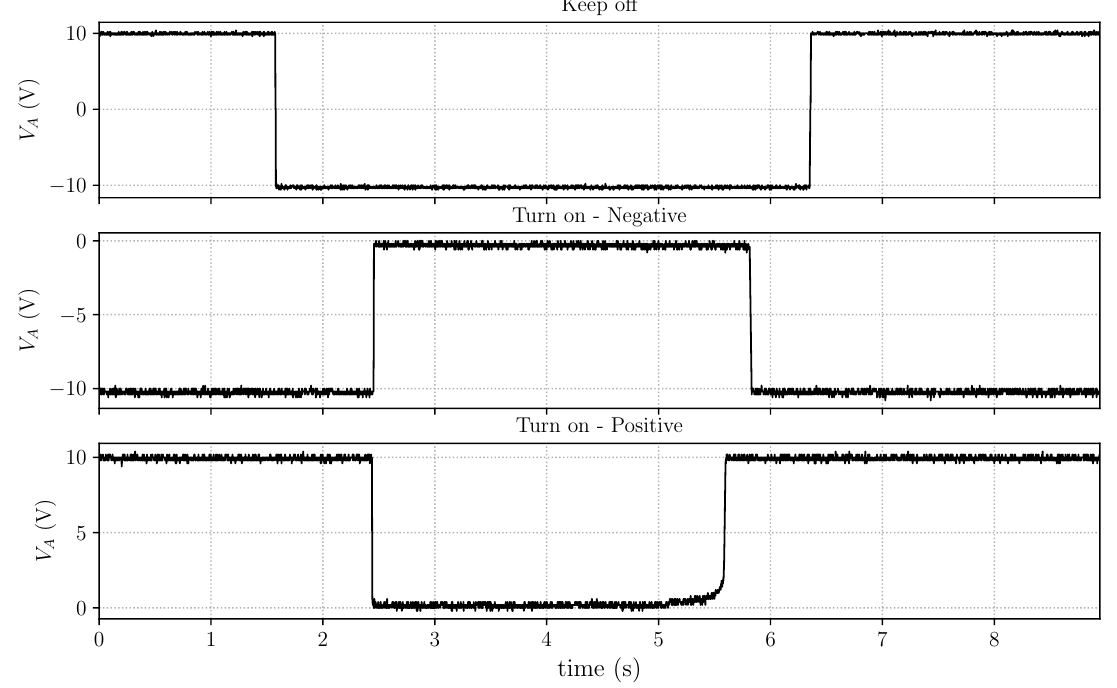
Figure 13. The bidirectional switch under testing. ( top ) The switch blocks HV in both polarities. ( middle ) The switch is turned on and off under negative polarity. ( bottom ) the switch is turned on and off under positive